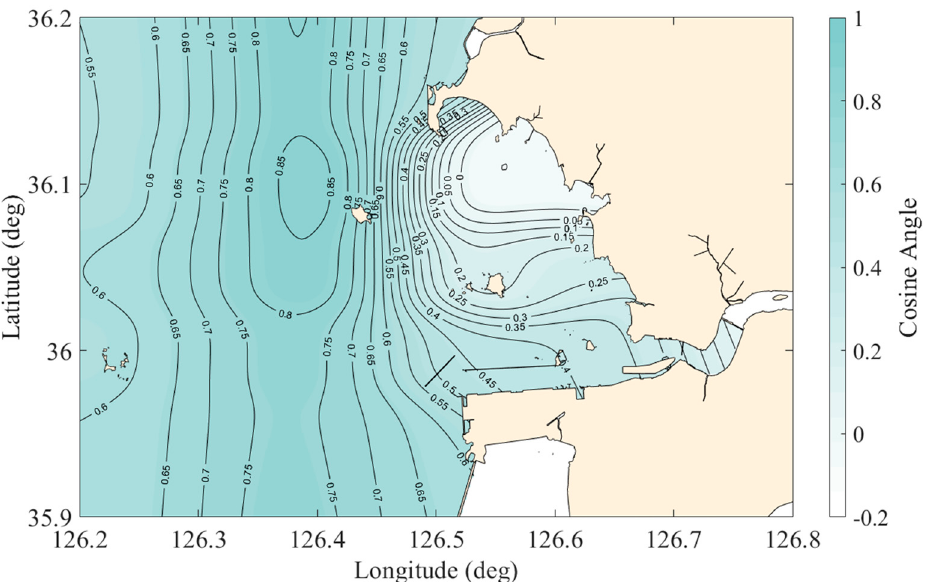
Figure 4. The spatial distribution of the true field of cosine angle composed of 38 points arranged at first.